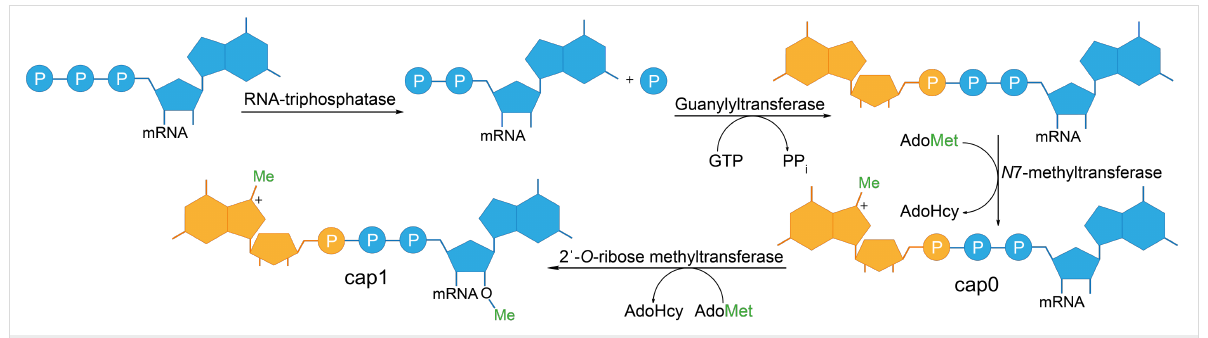
Figure 1: Schematic representation of enzymatic 5 ′ -cap formation in eukaryotic mRNA. The 5 ′ -triphosphate-end of the pre-mRNA is hydrolyzed to a diphosphate by an RNA 5 ′ -triphosphatase. A guanylyltransferase transfers GMP onto the β -phosphate of the 5 ′ -diphosphate to form a 5 ′ to 5 ′ -triphos- phate linkage. The guanine is methylated at the N 7-position by an RNA (guanine- N 7)methyltransferase, yielding the cap0 structure. Further methyla- tion at the 2 ′ -OH position of the first nucleotide results in formation of the cap1